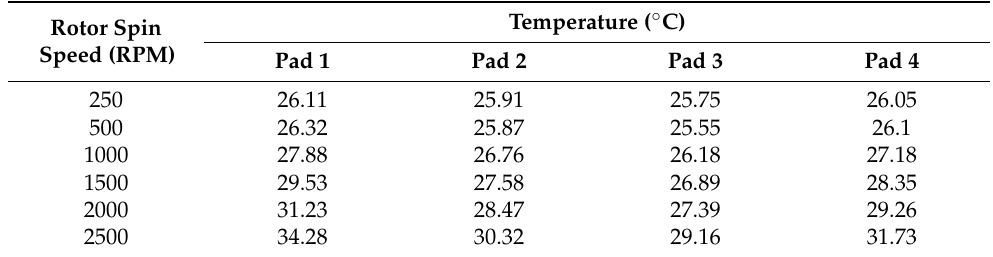
Table 3. Maximum lubricant temperature for relative eccentricity equal to 0.6 and different rotor speeds. Rotor Spin Speed